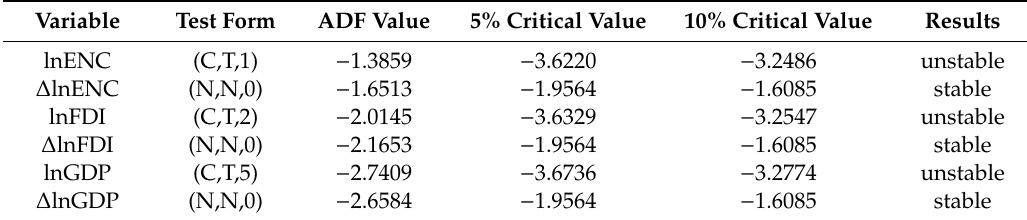
Table 5. Results of the augmented Dickey-Fuller (ADF) unit root